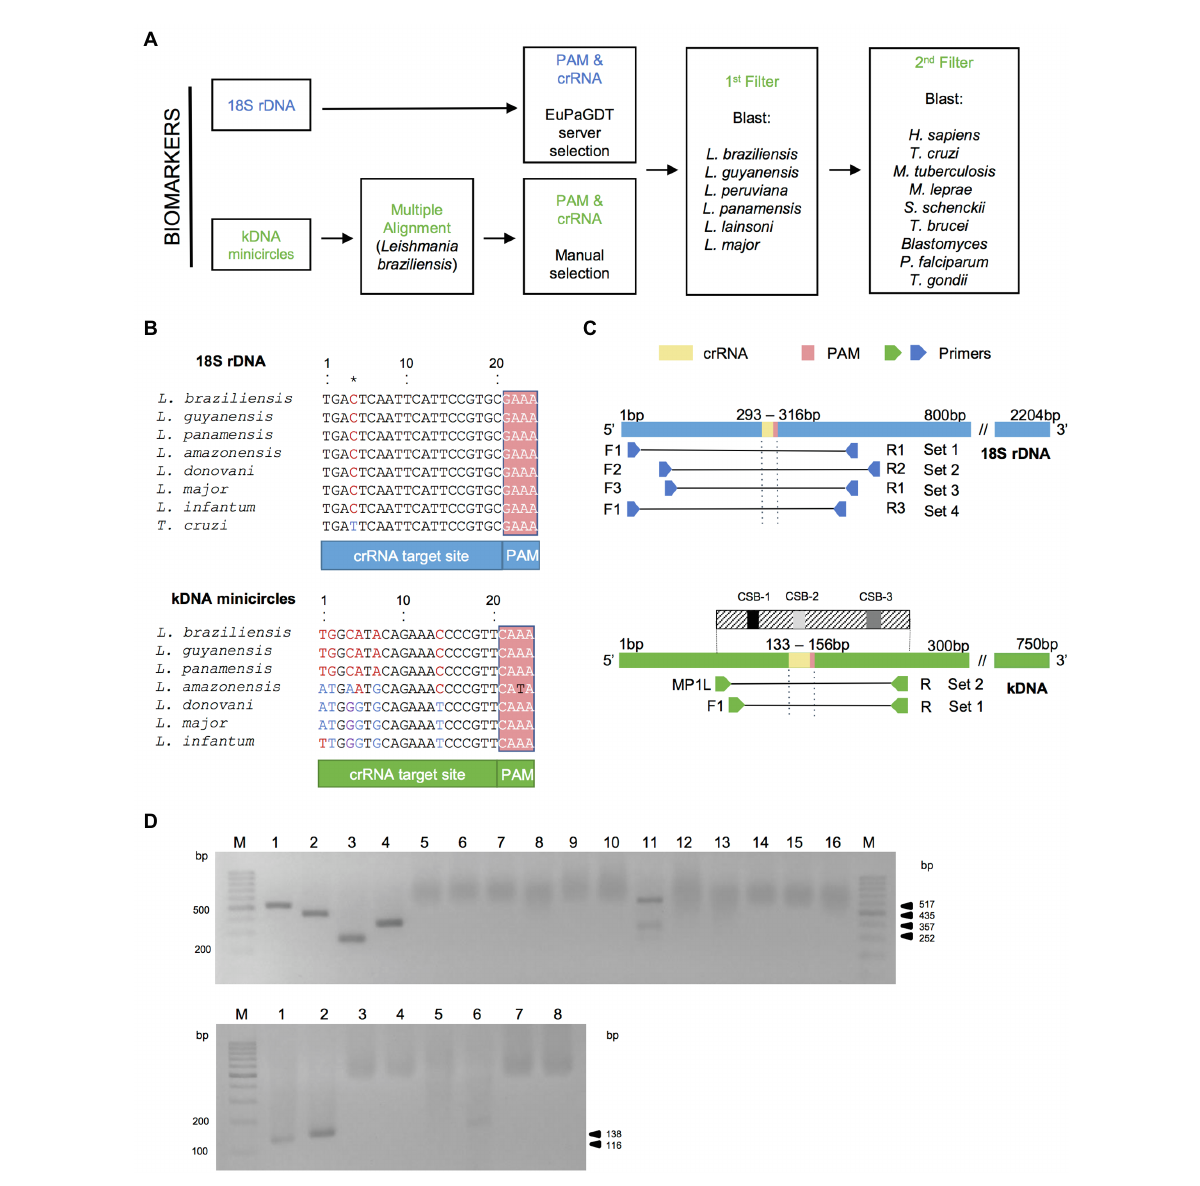
FIGURE 2 Bioinformatics analysis for crRNA and primer sets design. (A) Bioinformatics workflow for crRNA filtered selection for Leishmania kDNA minicircle and 18S rDNA biomarkers (see “Materials and Methods” for details). (B) Alignments of the target DNA sequence (that is complementary to the crRNA guide sequence) and flanking PAM from seven strains representative of different Leishmania species for the two targets and the Trypanosoma cruzi Y strain for the 18S rDNA target (the kDNA alignment including T. cruzi Y strain resulted in a 21 bp gap in the crRNA). Aligned sequences of the 18S rDNA gene concerned the strains: L. ( V. ) braziliensis MHOM/BR/75/M2904 2019 (TriTrypDB ID code: LbrM.27.2.208560), L. ( V. ) guyanensis MHOM/BR/1975/M4147 (GenBank accession number: X53913), L. ( V. ) panamensis MHOM/PA/94/PSC-1 (TriTrypDB ID code: LPMP_27rRNA1), L. ( L. ) amazonensis MHOM/BR/1973/M2269 (TriTrypDB ID code: LAMA_000552800), L. ( L. ) donovani MHOM/ET/67/HU3 (isolate LV9, TriTrypDB ID code: LdLV9.00.2.200020), L. ( L. ) major MHOM/IL/80/Friedlin (TriTrypDB ID code: LmjF.27.rRNA.06), L. ( L. ) infantum